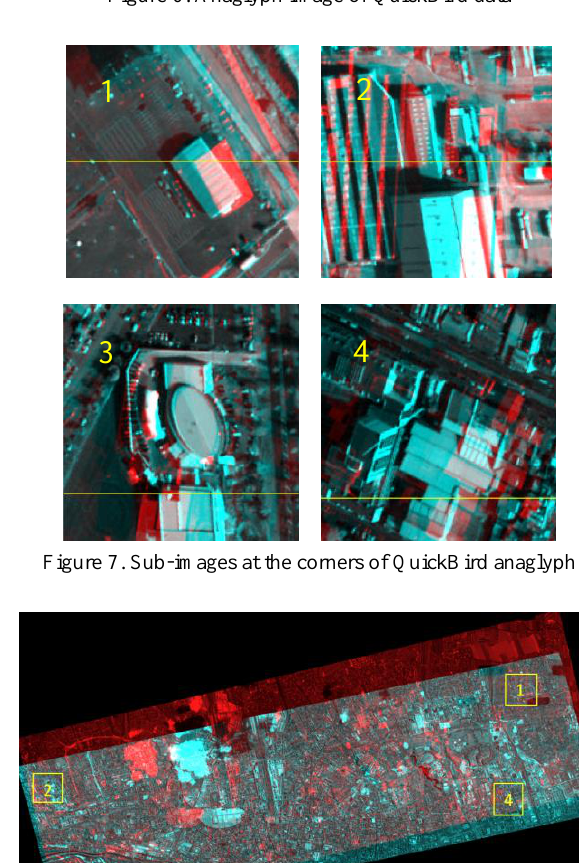
In Figure 10, the blue points show the y-parallaxes of the corresponding points, and the red line indicates where one pixel parallax locates. As Figure 10(a) has shown, for QuickBird data, five of the forty check points have y-parallaxes larger than 1 Figure 8. Anaglyph image of WorldView-2 data pixel but less than 1.5 pixels. According to Figure 10(b), 15 points among the 260 corresponding points have the y- parallaxes larger than one pixel for WorldView-2 dataset.